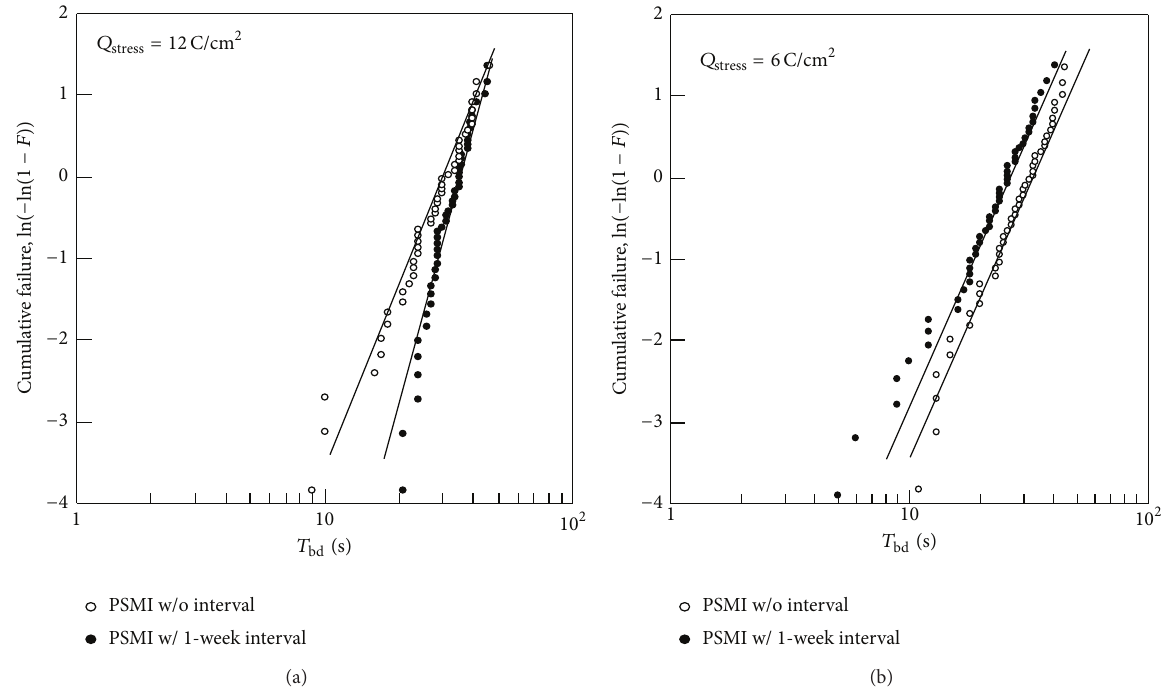
distribution for 𝑄 of 12 C/cm 2 . Open circles show the 𝑇 bd stress distribution for multiple PSMI experiments with the interval of a week. (b) 𝑇 bd distribution for PSMI without interval. Closed circles show the 𝑇 bd